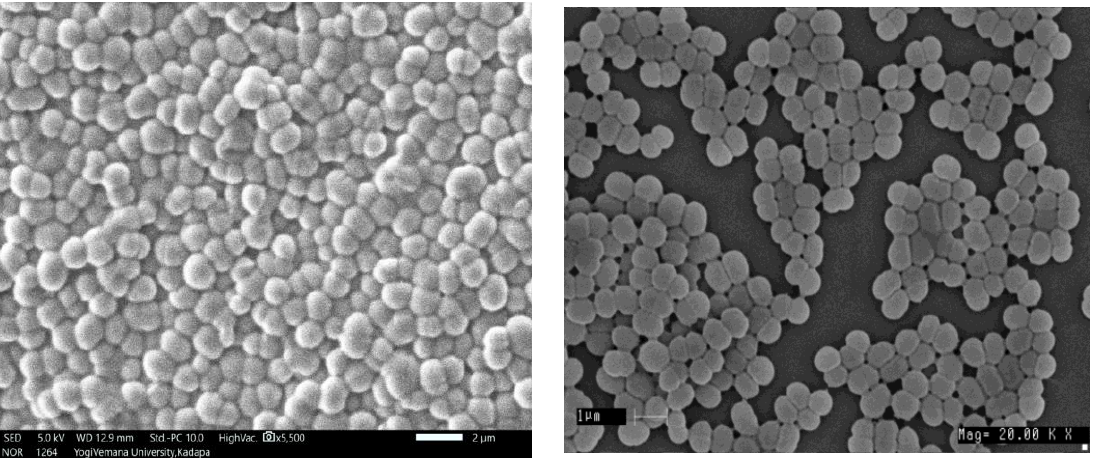
Figure 1. Scanning electron microscopic images of Pediococcus sp. HLV1 at 20 KX magnification.